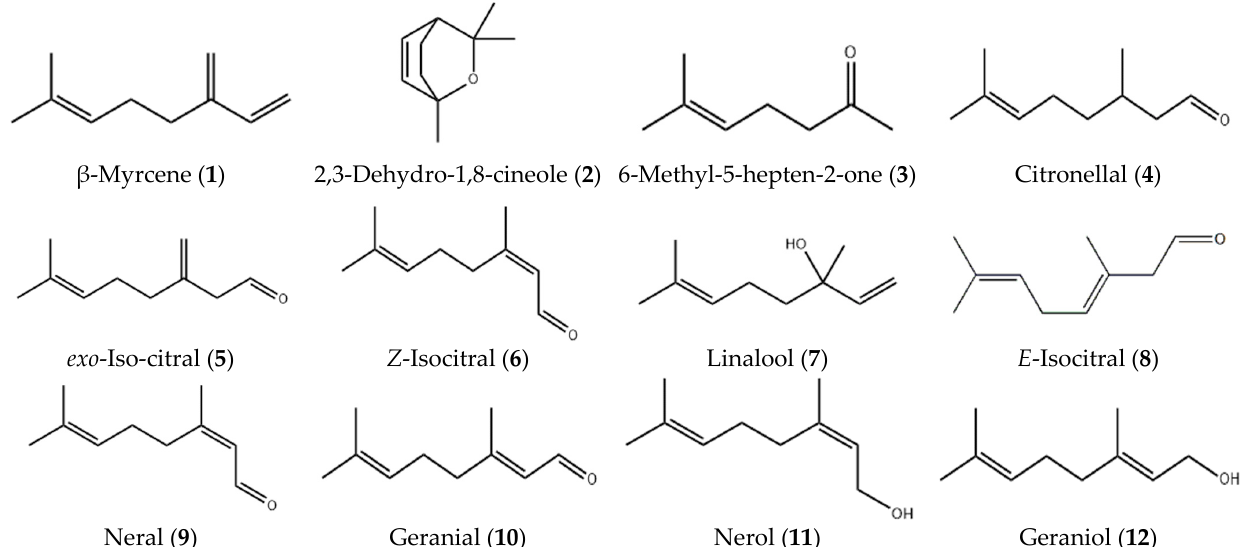
Figure 2. Major constituents of B. citriodora essential oil.